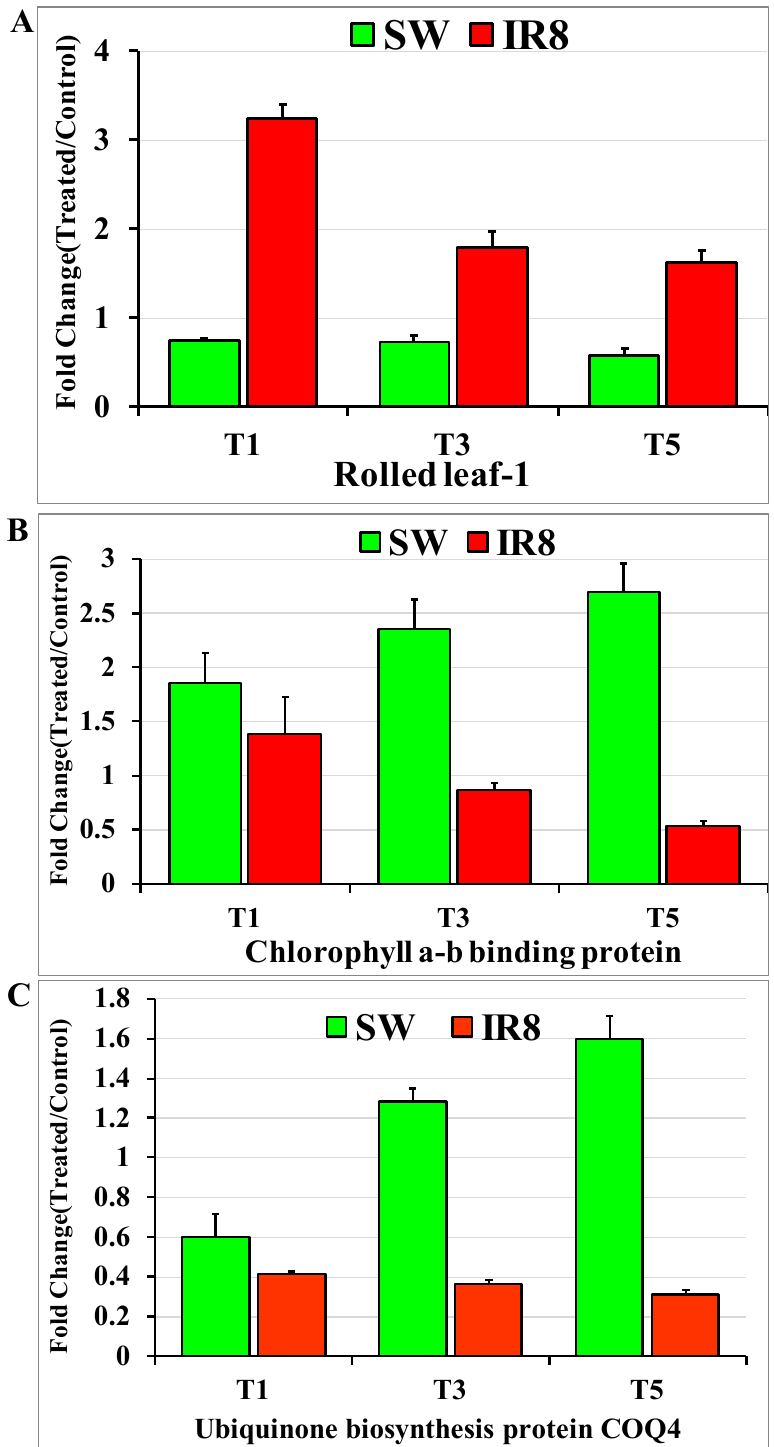
Figure 7. Expression analysis of target genes of identified three known miRNAs in T1, T3, and T5 samples of Swarnaprabha (SW) and IR8 with respect to control. ( A ) Rolled leaf-1 expression, a target of miRNA osa-miRNA166c-3P , ( B ) chlorophyll a-b-binding protein, a target of miRNA osa-miR2102- 3p , ( C ) ubiquinone biosynthesis protein COQ4, a target of miRNA osa-miR530-3p. Each gene was amplified using gene-specific primers designed using Primer Blast Tool. Actin was taken as an internal positive control. The primer sequences are provided in Table S3. Error bars are ± SD of the average of three q RT-PCR